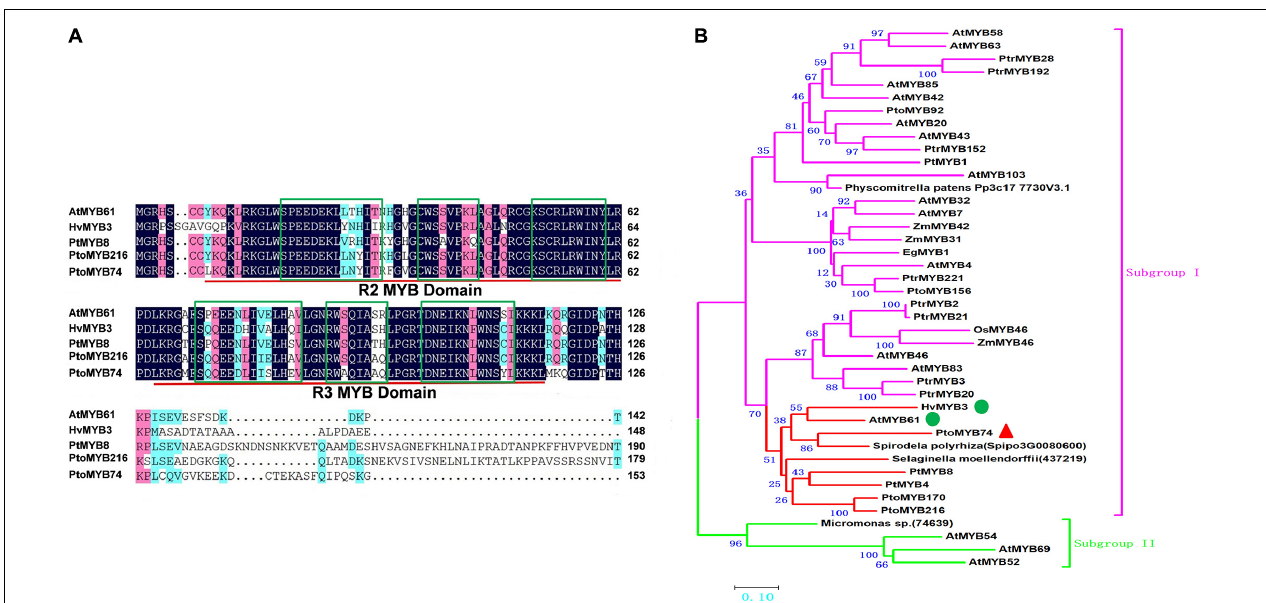
FIGURE 1 | PtoMYB74 is highly conserved with many R2R3-MYB transcription factors. (A) Amino acid sequence alignment of the N-terminal region of PtoMYB74 with AtMYB61 ( A. thaliana ), HvMYB3 ( H. vulgare ), PtMYB8 ( P. taeda ), and PtoMYB216 ( P. tomentosa ). Sequences were aligned with the software of DNAMAN 8. Numbers on the left side refer to its sequence positions. The R2 and R3 repeats are indicated with red bars, and the Helix-Turn-Helix motifs are marked with green boxes. Blue and pink shades are used to show the identification and similarities of the amino acid residues, respectively. (B) Phylogenetic analysis of PtoMYB74 with selected R2R3-MYB transcription factors which are involved in secondary cell wall formation. Full-length of amino acid sequences were aligned with Clustal W, and the phylogenetic tree was constructed using MEGA 6.0 using the neighbor-joining method (2500 bootstrap replicates) and p-distance model. Bar = 0.1 substitutions per site. The Subgroup I is indicated with fuchsine bars, and the Subgroup II is marked with mint green bars. In the Subgroup I, PtoMYB74 and its homologous genes are prominently displayed in the red bars. GenBank accession numbers of MYB transcription factors sequences are given in the Supplementary Table S2